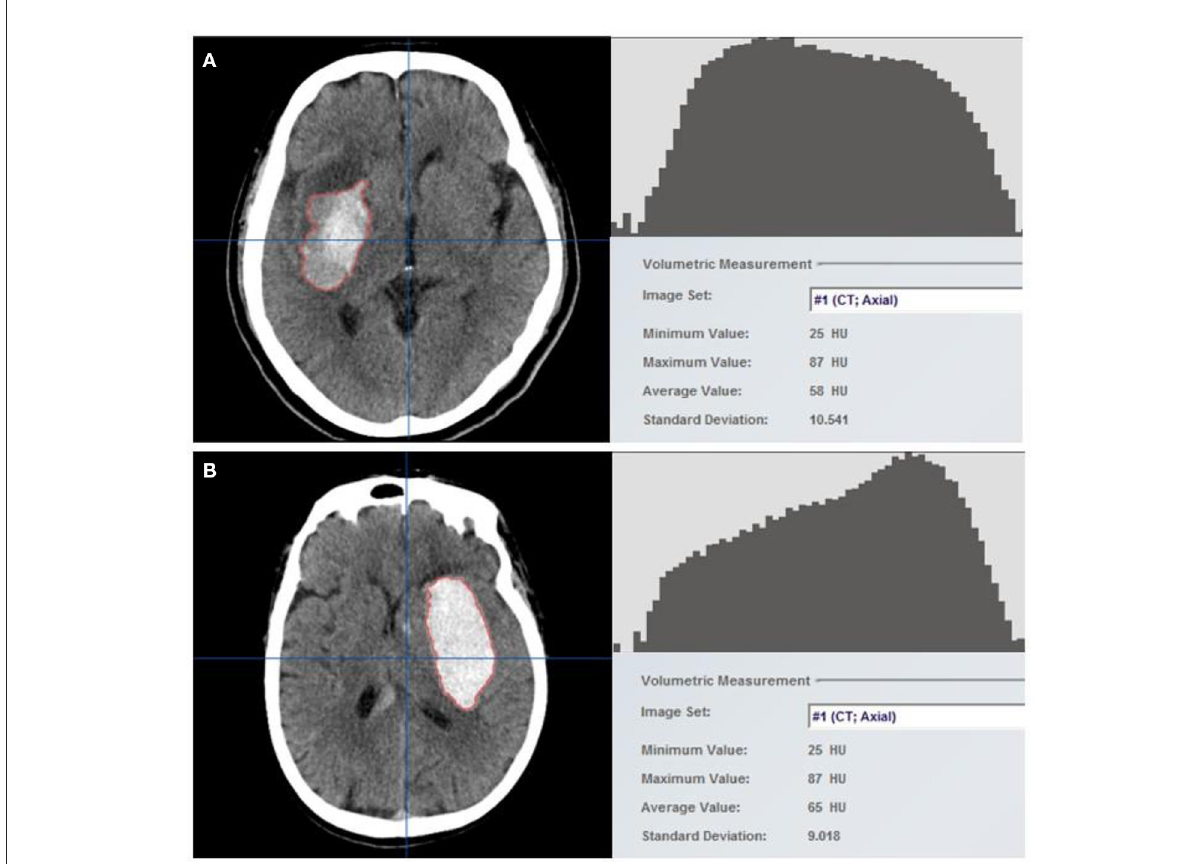
FIGURE1 Hematomas were identified using the semi-automatic edge detection tool included in neuro-navigation workstation software (left) . The auto-segmentation function was used to process the region of interest (ROI), which constituted the entire hematoma, to obtain the Hounsfield unit histogram and density-related parameters (right) . Two example cases with ( A ) and without ( B ) hematoma growth are shown. Hounsfield units (HUs) are generally discrete in patients with hematoma growth, with a higher coefficient of variation (CV) of 18%, but are concentrated in patients without hematoma growth, with a CV of